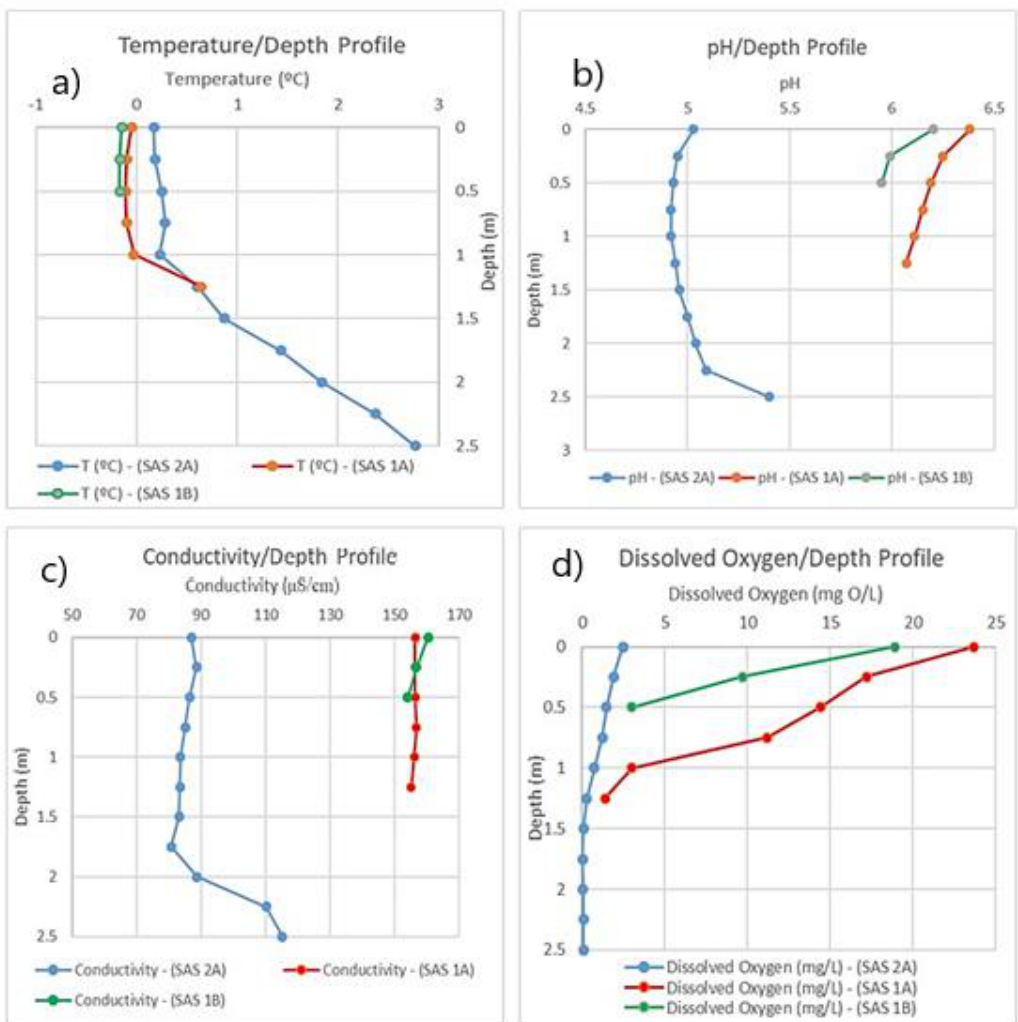
Figure 2. Vertical profiles of physicochemical variables. Blue: Lake SAS 2A; Red: Lake SAS 1A; Green: Lake SAS 1B. ( a ) Temperature; ( b ) pH; ( c ) Electrical conductivity; ( d ) Dissolved oxygen. The lower ice surface was set as 0 m depth for all cases.